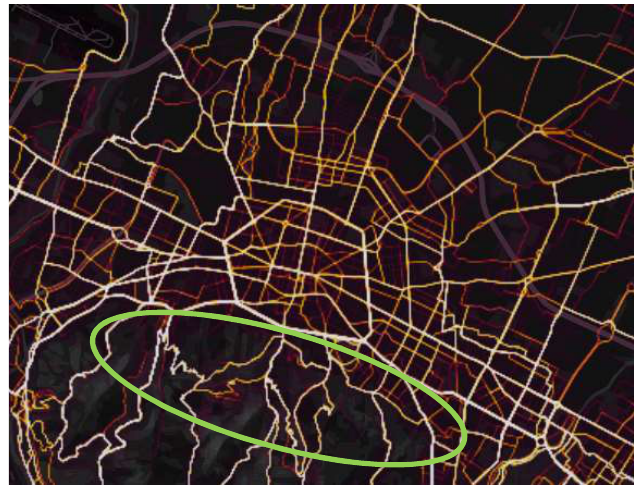
Figure 8. The Strava heat-map of Bologna.